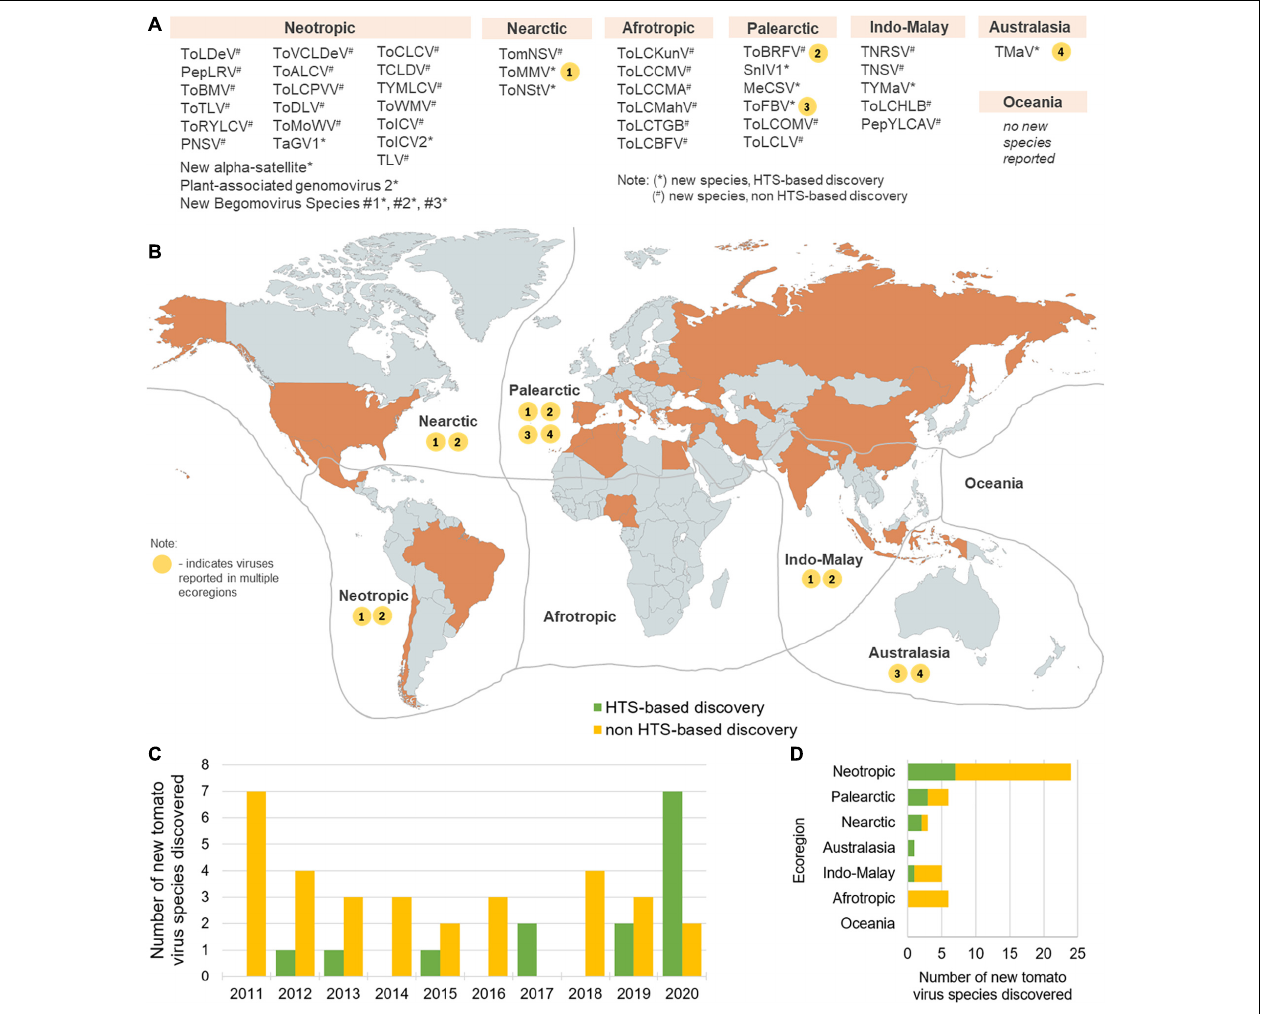
FIGURE 1 | Global distribution of virus species newly discovered in the 2011 to 2020 period. Abbreviated virus names (see Table 1 ) are shown in groups corresponding to the ecozones in which they were discovered (Antarctic is not shown, for simplicity, China and Indonesia are included in Indo-Malay, and Mexico is included in the Neotropic ecoregion) (A) . In the map (B) , ecoregions are delimited by gray lines and countries colored in orange are top producers of tomato in the 2008–2018 period, recording at least 8.14 million tons of total tomato produced (FAOSTAT, 2020). Viruses detected in more than one ecozone are shown on the map as number-coded yellow circles (1–4) corresponding to the virus species designated in the list in (A) . The numbers of annual new tomato virus discoveries in the 2011–2020 period are shown in (C) and the numbers of new tomato virus discoveries per ecoregion in this time period are shown in (D) . The map was created using www.mapchart.net under the CC BY-SA 4.0